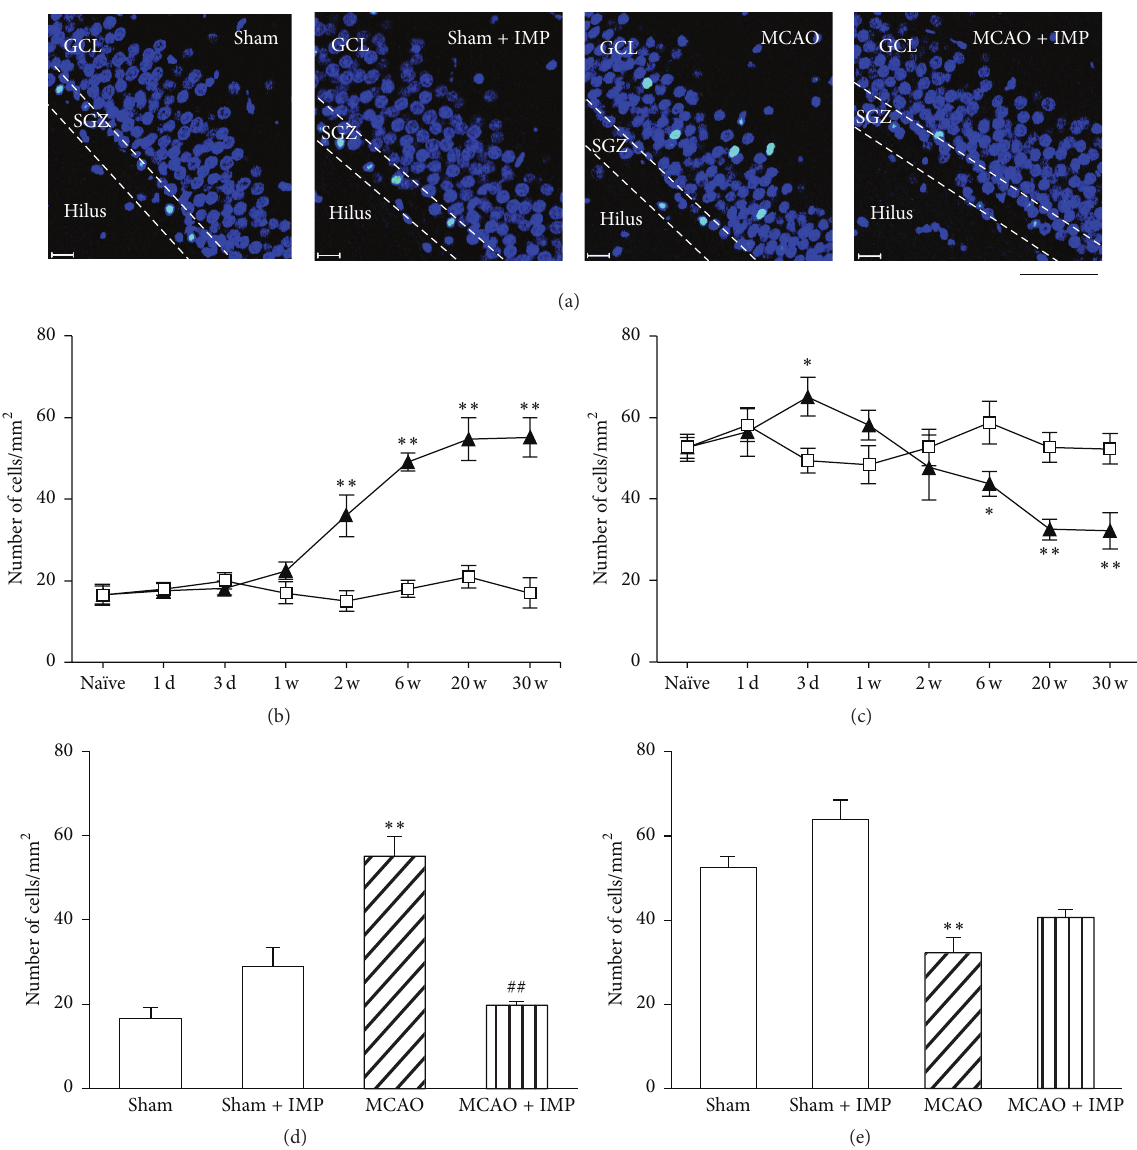
Figure 7: Analysis of the number of cleaved caspase-3 immunopositive cells in ipsilateral GCL and SGZ. (a) Typical images of the slices taken at 30 weeks after MCAO. Blue signal is the nuclei stained with H¨ochst 33258, while green signal of FITC is from cleaved caspase-3 immunopositive cells. Scale bar indicates 50 𝜇 m. (b, c) Time course changes of cleaved caspase-3 immunopositive cells after MCAO in GCL (b) and SGZ (c). Symbols used are as follows: open square, sham; closed triangle, MCAO. Statistical significance was evaluated with two- = 21.2 , 𝐹 = 129.6 , 𝐹 = 19.1 , 𝑡 = 3.71 , way ANOVA followed by unpaired 𝑡 -test at each time point (GCL: 𝐹 ( ( group )1 ( time ∗ group )7,64 (2 w ) time )7 = 12.35 , 𝑡 = 6.24 , and 𝑡 = 7.53 ; SGZ: 𝐹 = 4.50 , 𝐹 = 5.84 , 𝐹 = 6.06 , 𝑡 = 3.29 , 𝑡 = −2.79 , 𝑡 (6 w ) (20 w ) (30 w ) ( time )7 ( group )1 ( time ∗ group )7,64 (3 d ) (6 w ) = −4.86 , and 𝑡 = −3.95 ; ∗ 𝑃 < 0.05 and ∗∗ 𝑃 < 0.01 versus sham). (d, e) Analysis of the effect of IMP (20 mg/kg/day for 29 weeks) on 𝑡 (20 w ) (30 w ) the number of cleaved caspase-3 immunopositive cells at 30 weeks after MCAO in GCL (d) and SGZ (e). Statistical significance was evaluated = 24.63 ; 𝐹 = 18.41 ; ∗∗ 𝑃 < 0.01 versus sham [IMP( − )]; with one-way ANOVA followed by Tukey-Kramer post hoc test ( 𝐹 ( ( SGZ )3,16 GCL )3,16 ## 𝑃 < 0.01 versus MCAO [IMP( − )]; 𝑁 = 5